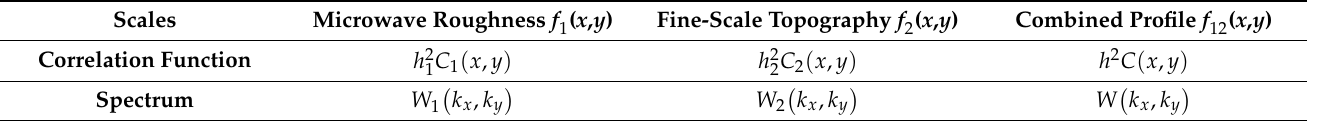
Table 6. Descriptions of f 1 ( x , y ) , f 2 ( x , y ) , and f 12 ( x , y )